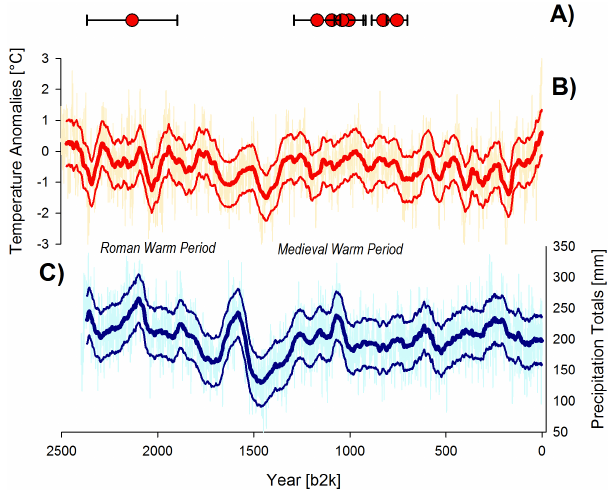
Fig. 6. (A) U-series ages of coarse crystalline cryogenic cave car- bonates (CCC coarse ) from Leclanch´e Cave plotted against (B) June- July-August temperature anomalies and (C) April-May-June pre- cipitation totals over the last 2500yr reconstructed from Central European tree-rings (B ¨ untgen et al., 2011).